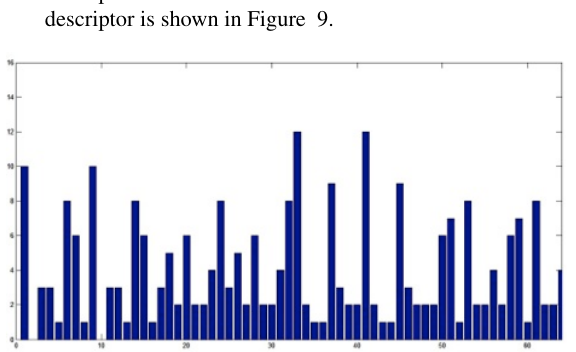
Figure 9: Final descriptor after concatenation